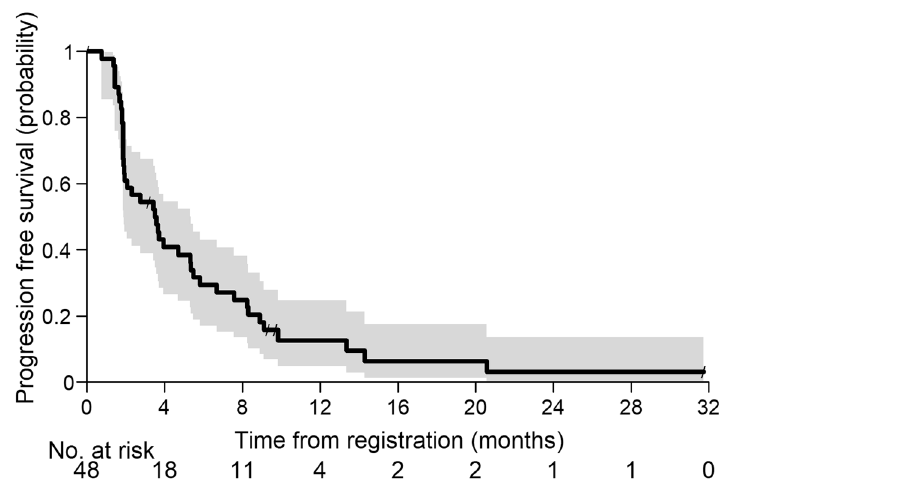
Figure 2. Progression free survival in the full analysis